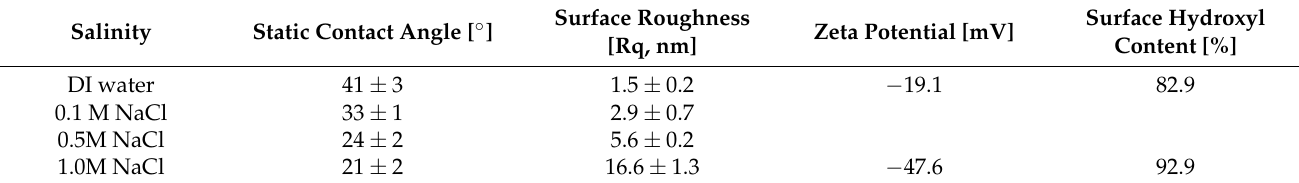
Table 1. Surface properties of biotite after biotite reacted with CO 2 for 70 h under different salinity conditions (modified from